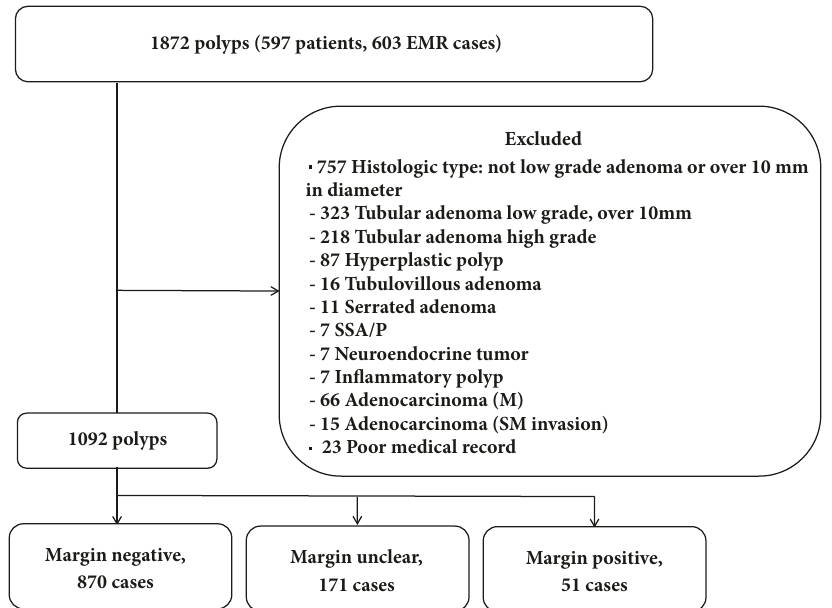
Figure 1: Flow diagram of this study. After EMR, each polyp was categorized into the negative-margin group, unclear-margin group, or positive-margin